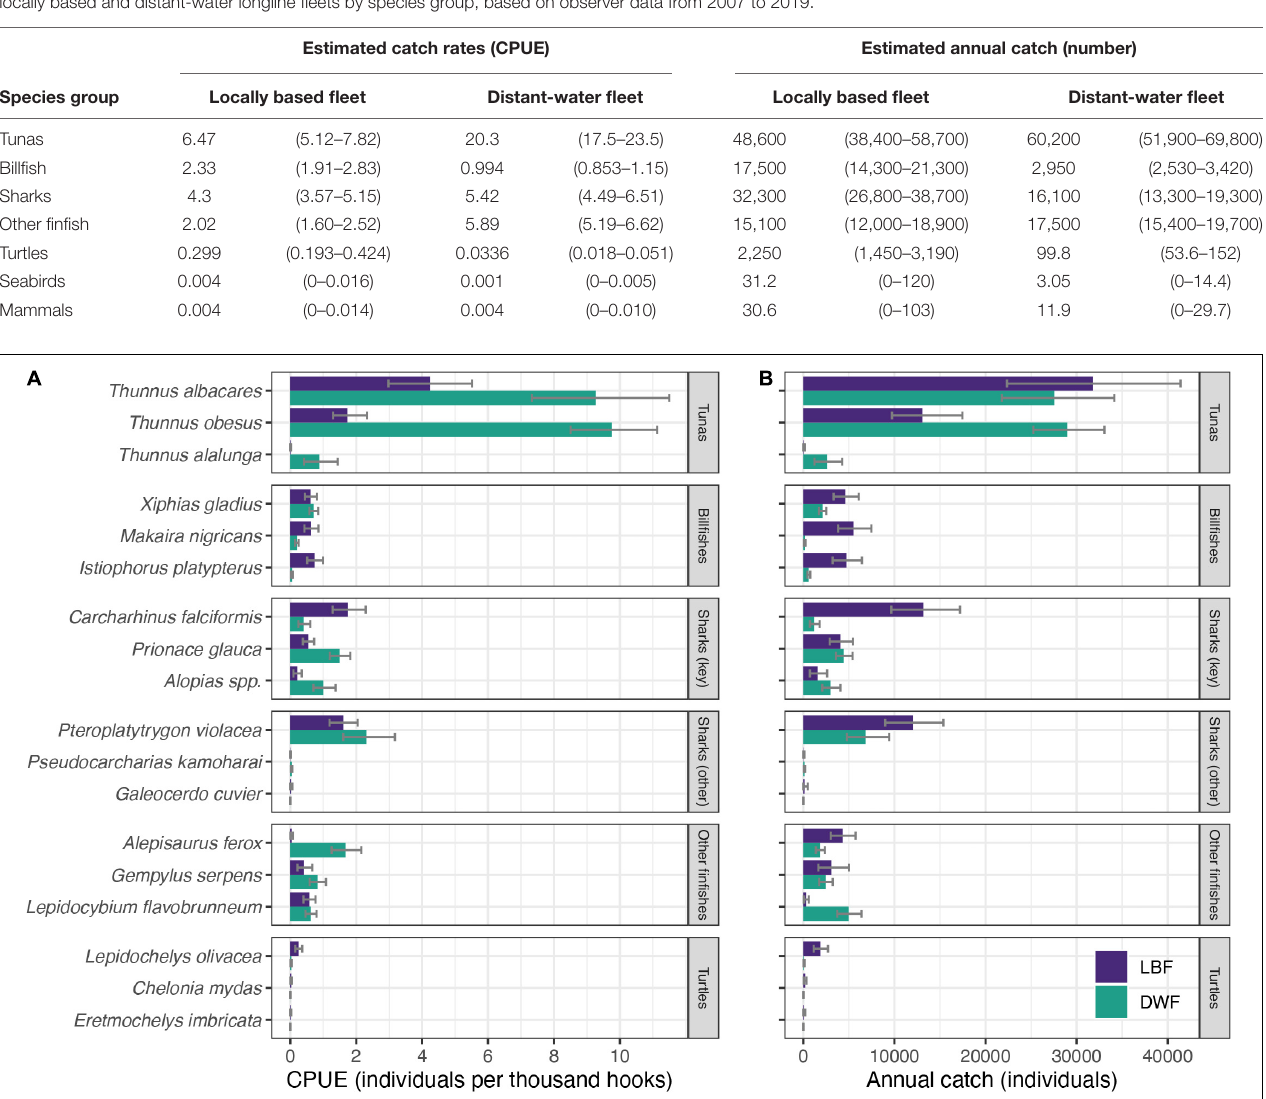
TABLE 1 | Estimated catch rates (numbers per ‘000 hooks, 95% confidence interval (CI) in parentheses) and annual catch (numbers; 95% CI in parentheses) for the locally based and distant-water longline fleets by species group, based on observer data from 2007 to 2019.